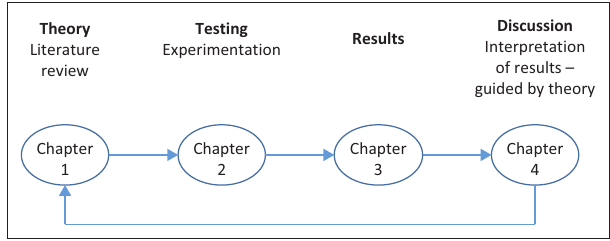
FIGURE 3: Theory in quantitative research designs.